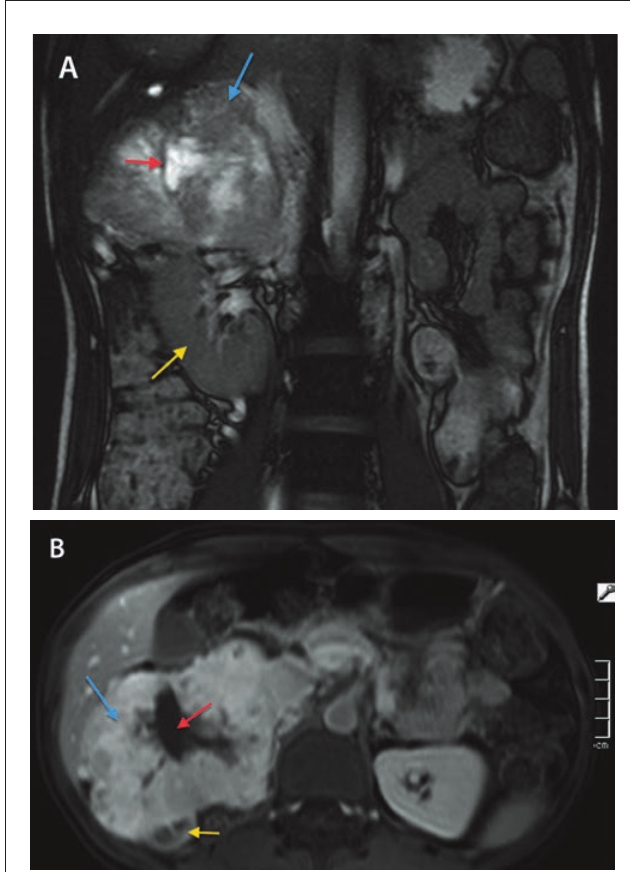
arrows).Fig. 8. Histologically proven phaeochromocytoma in a 56-year-old man. (A) Coronal T2-weighted image showing a heterogeneous right suprarenal mass (blue arrow) with central necrosis (red arrow), displacing the kidney inferomedially (yellow arrow). (B) Axial gadolinium-enhanced T1-weighted image demonstrates intense enhancement (blue arrow). Central non- enhancing area corresponds to the area of central necrosis (red arrow).